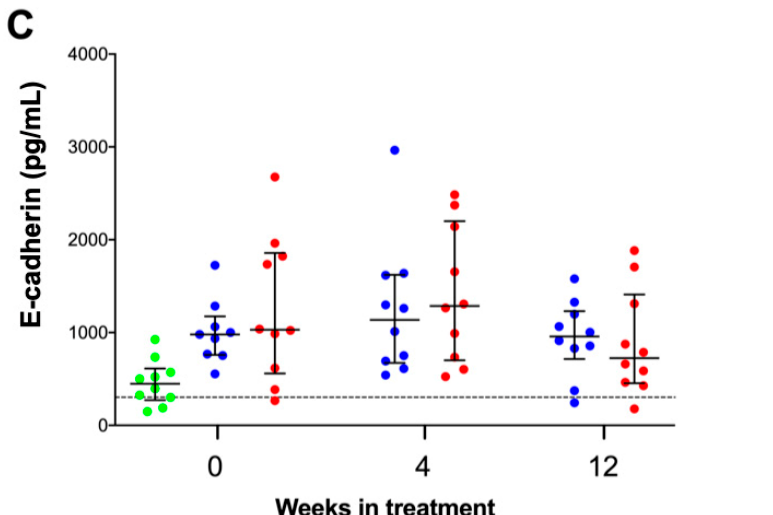
Figure 10. Plasma levels of PDL-1 increased, while PDL-2 and E-cadherin plasma levels were not modified in KS/HIV patients. PD-L1, PD-L2 ( A , B ), and E-cadherin ( C ) were measured in plasma at the baseline (W 0 ) between KS/HIV and HIV+ patients and across the follow-up in each group. The black dashed line represents the median value of HIV-negative men. Green dots represent HIV+ asymptomatic men; blue dots represent CT and red MT participants. Data are represented as median values and IQR. Statistical comparisons were performed using the Kruskal–Wallis test, * p < 0.05.